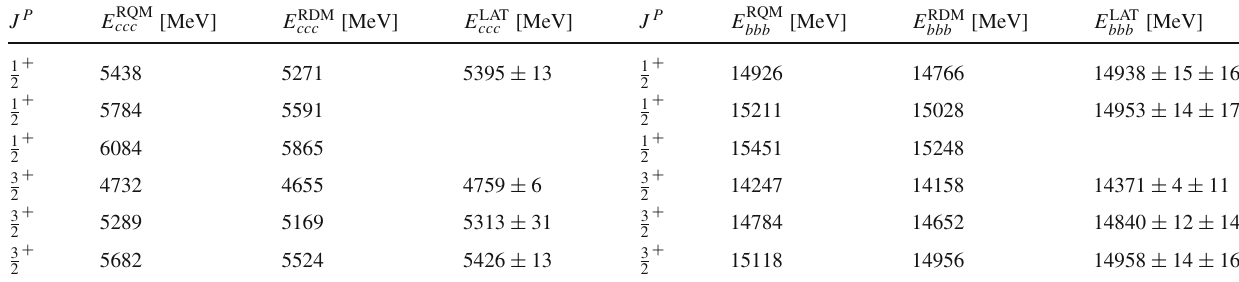
respectively, coupled to the total spin of the baryon, S ; the latter is coupled to the orbital angular momentum, L , to get the total angular momentum of the baryon, J P , with parity P . For J P = 1 where N = 1 , 2 , 3. Our results are compared with those of lattice QCD calculations, Ref. [87] for the (cid:11) ccc sector and Ref. [88] for the (cid:11) bbb